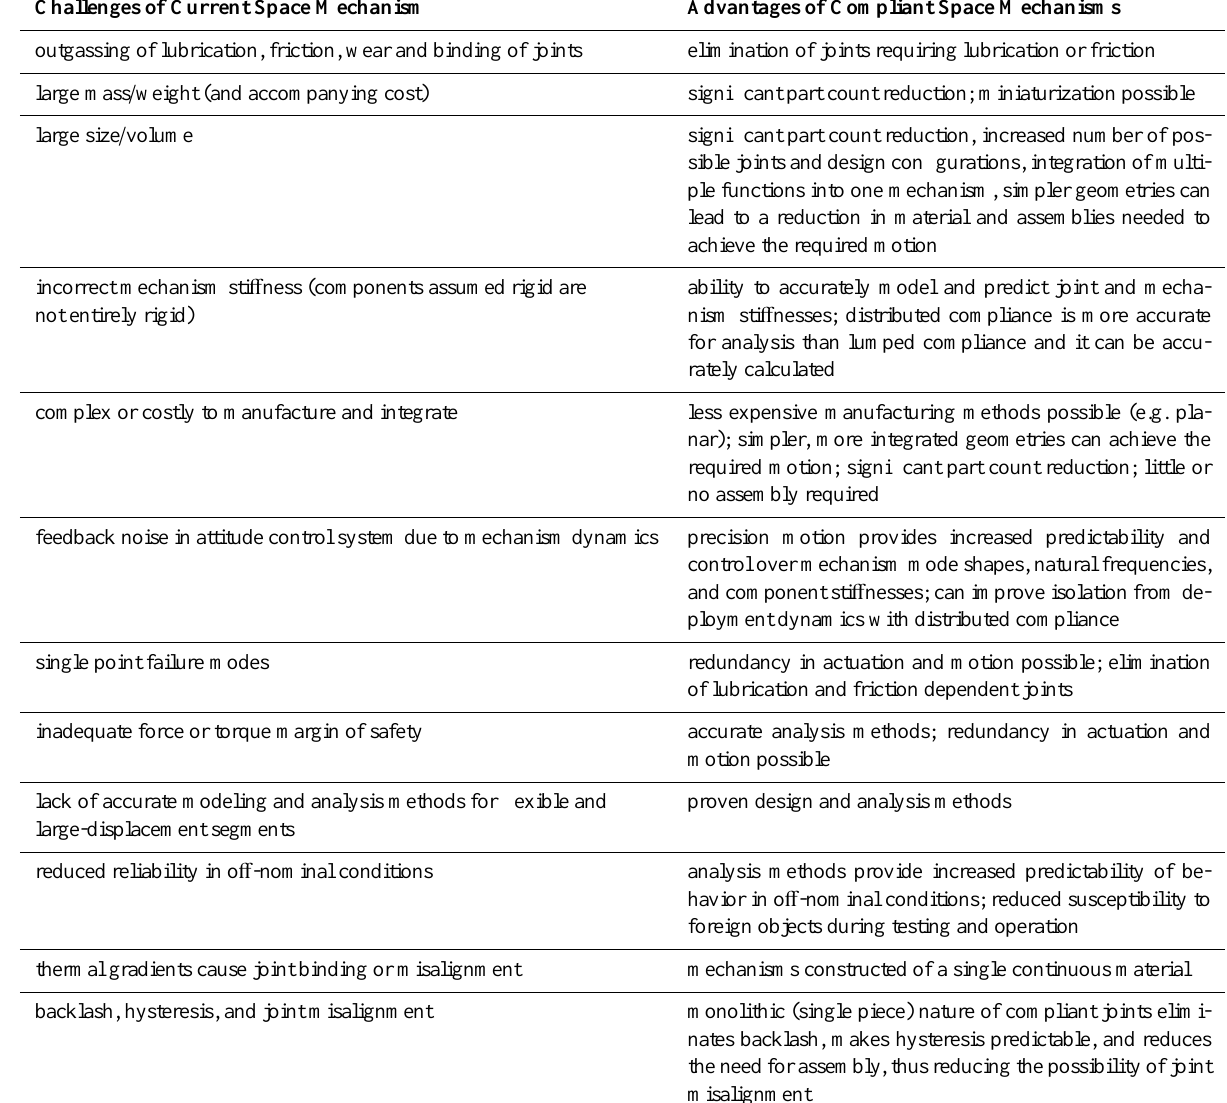
Table 1. Current space mechanism challenges and the advantages of compliant space mechanisms that overcome those